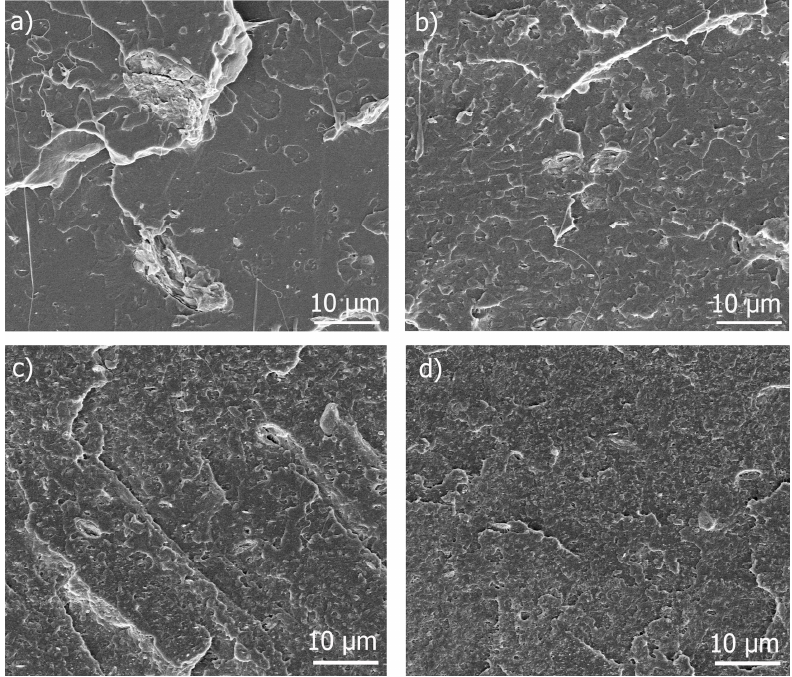
Figure 5. HR-SEM images of the cryogenic fracture of: ( a ) PLA-ChNC; ( b ) PLA-TEC2.5-ChNC; ( c ) PLA-TEC5.0-ChNC; and ( d ) PLA-TEC7.5-ChNC showing improved dispersion and distribution of ChNC with an increased TEC content.